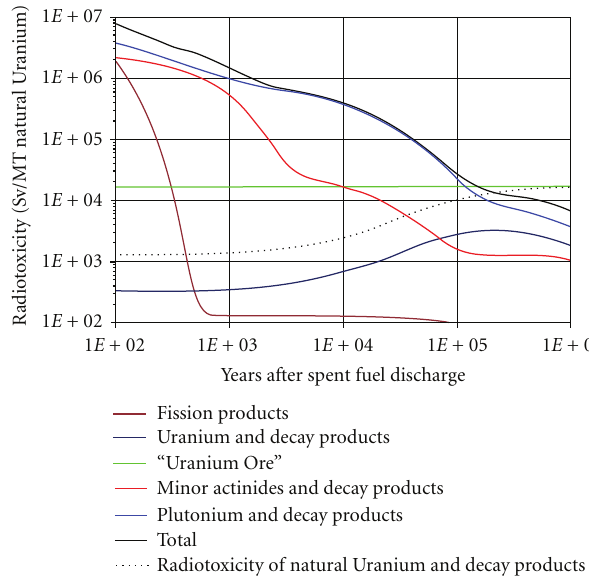
Figure 1: Radiotoxicity of SNF versus